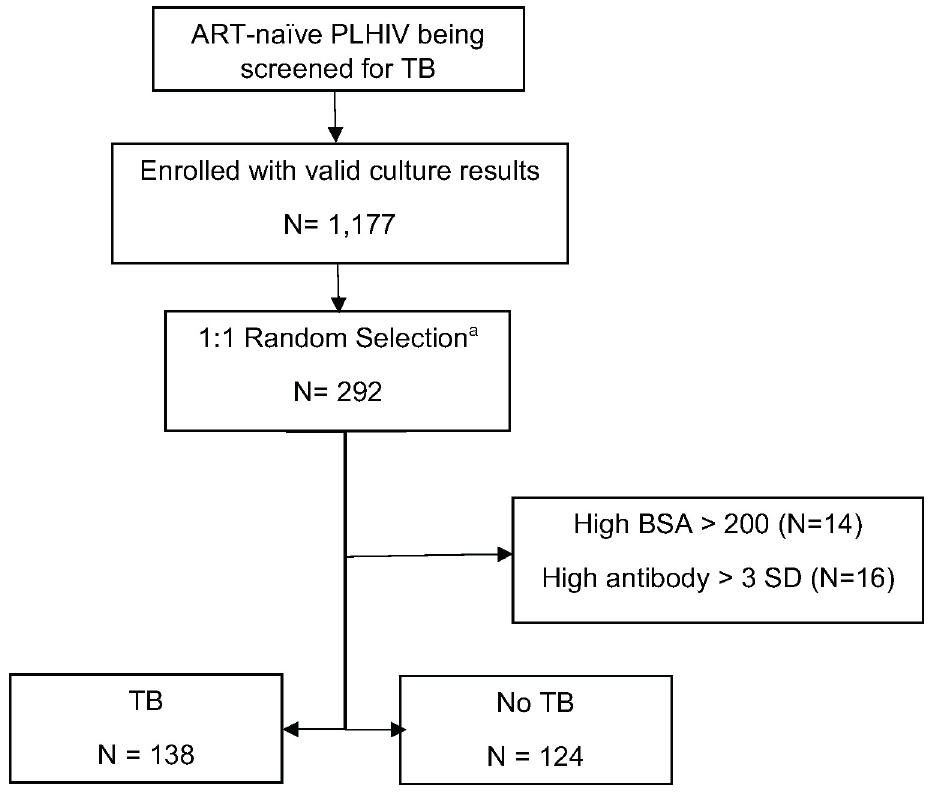
Fig 1. Flowchart of participants. a. 292 selected based on specimen availability, complete data, and cost ART: antiretroviral therapy; BSA: Bovine Serum Albumin; PLHIV: People living with HIV; SD: Standard Deviation; TB: